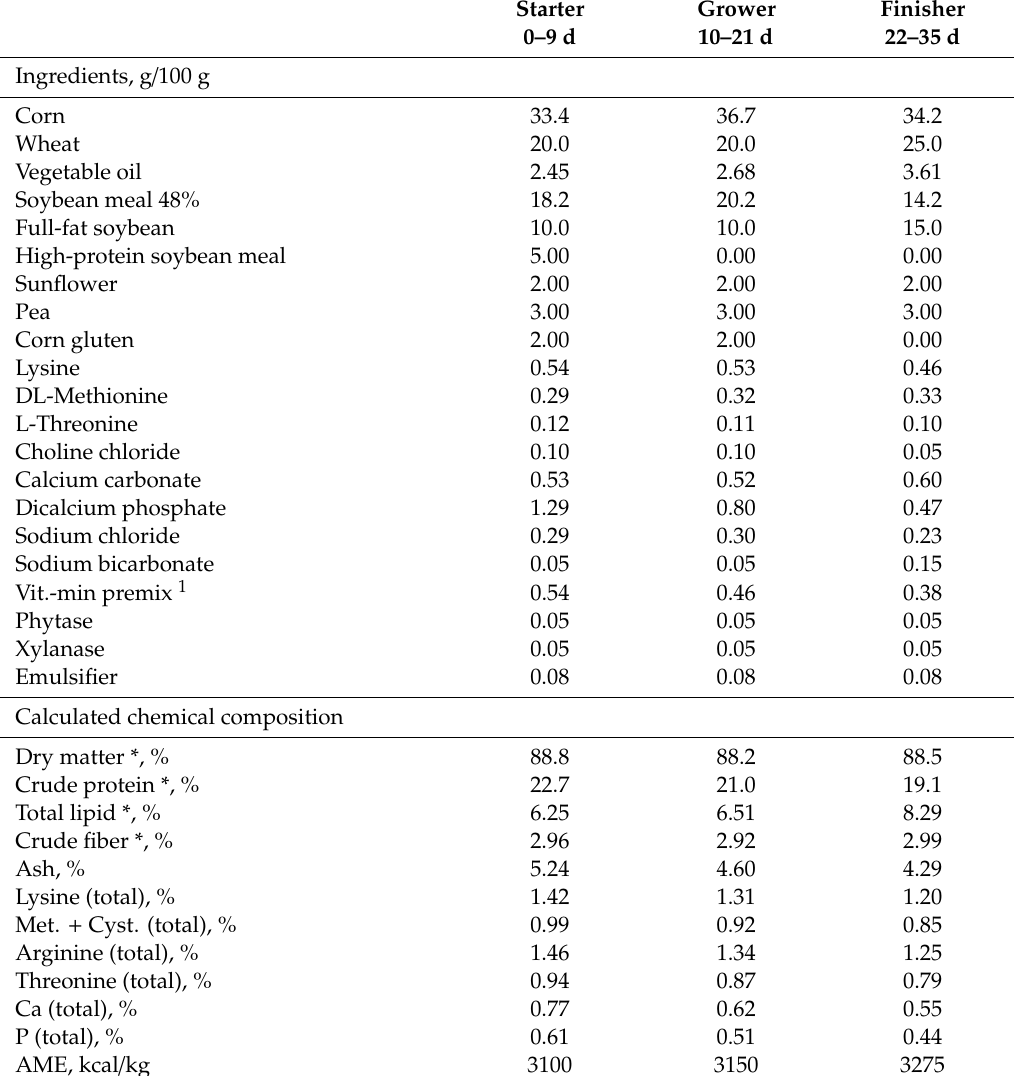
Table 1. Composition of the basal diet administered to both A and B hybrids in each feeding